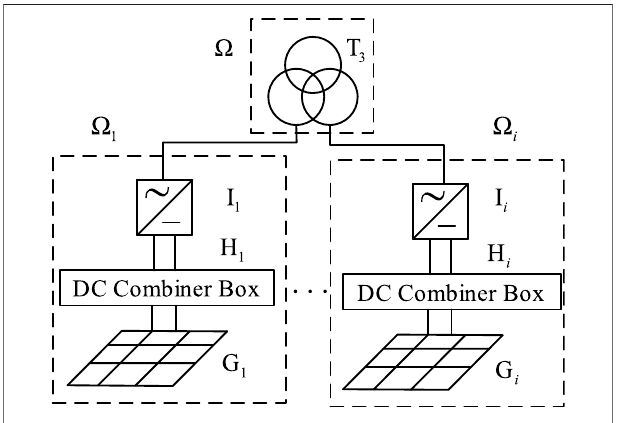
FIGURE 1 | Schematic diagram of the association set.